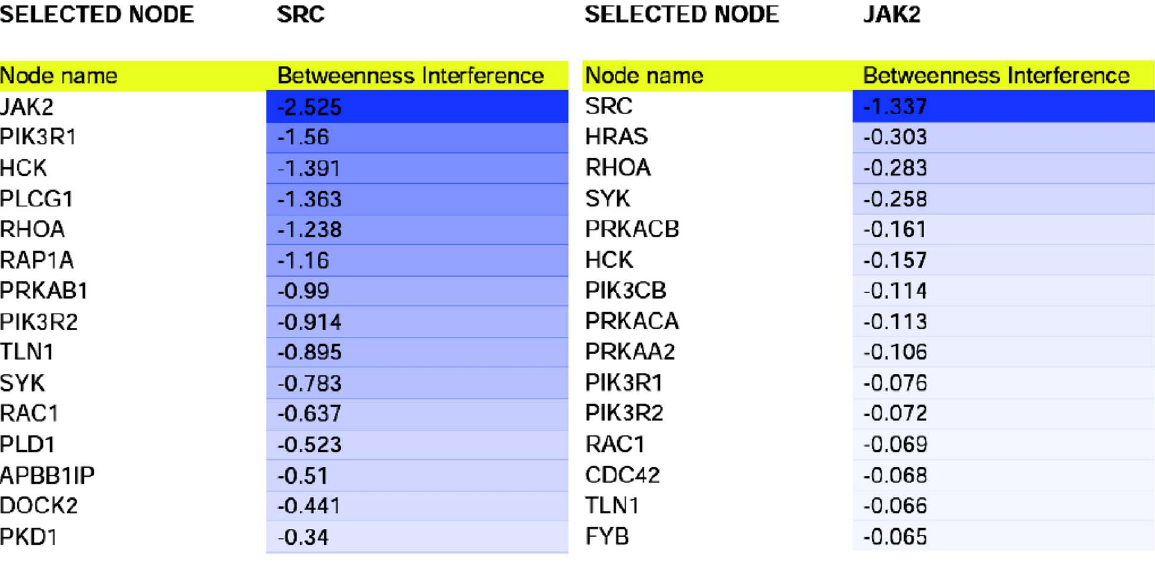
Figure 5. Interference of SRC and JAK2. First fifteen negative interference values of SRC and JAK2, expressed as percentage. Note the reciprocal high interference of SRC and